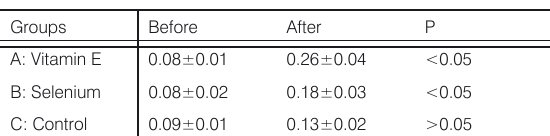
Table 1. The blood flow in wound regions in the right thigh before and after vitamin E and selenium administrations and in the control group. Data is presented as mean ± standard deviation